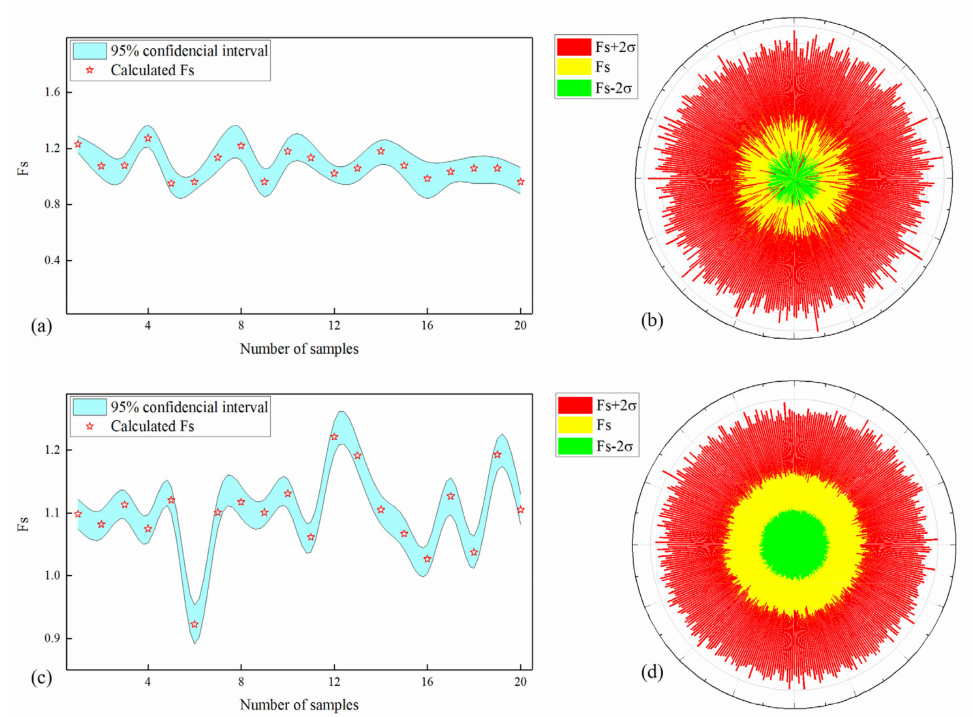
Figure 16. ( a ) F s calculated from SRM and 95% confidence levels of F s obtained from WOA-GPR RSM in Case 1; ( b ) F s and the corresponding 95% confidence level determined by the proposed model based on MCS with 5000 samples in Case 1; ( c ) F s calculated from SRM and 95% confidence levels of F s obtained from dynamic WOA-GPR RSM in Case 2; ( d ) F s and the corresponding 95% confidence level determined by the proposed model based on MCS with 5000 samples in Case